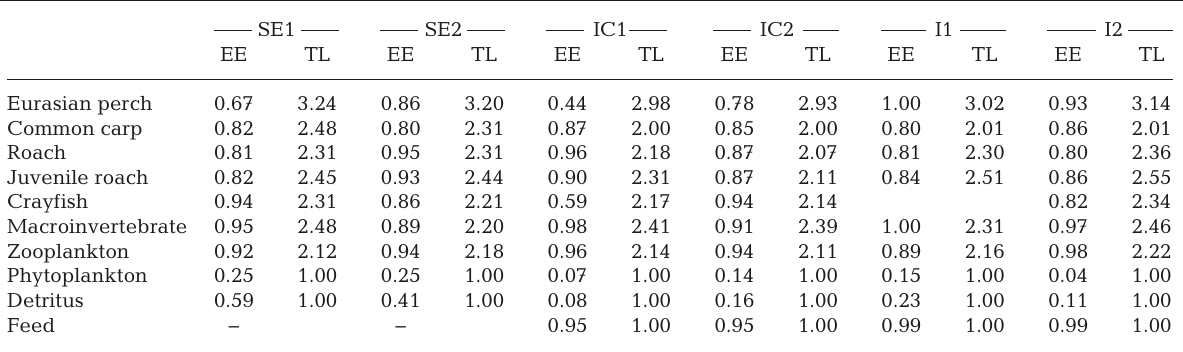
Table 4. Ecological performances calculated by Ecopath. EE: ecotrophic efficiency; TL: trophic level of the trophic groups in replicates 1 and 2 of the semi-extensive (SE), intensive-coupled (IC) and intensive (I)